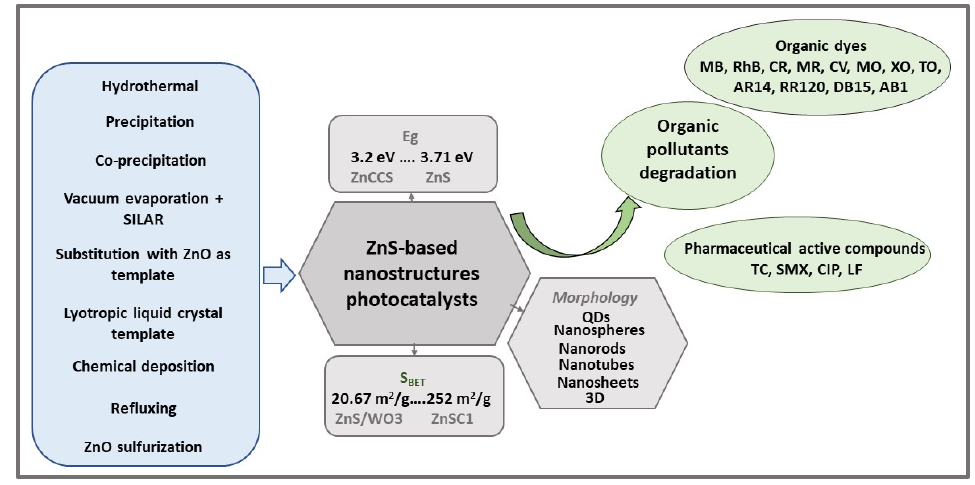
Figure 11. Summary of synthesis methods, specific properties, and applications in wastewater treatment of ZnS-based nanostructure photocatalysts.